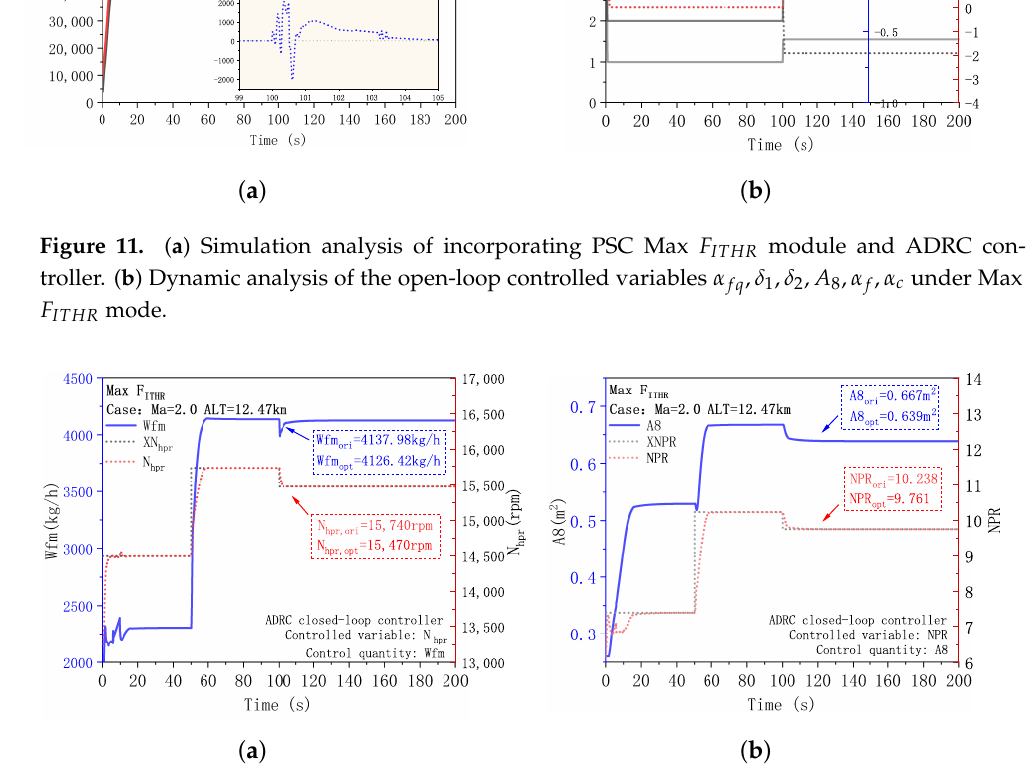
Figure 12. ( a ) Dynamic analysis of the controlled variables wfm and N hpr under Max F ITHR mode. ( b ) Dynamic analysis of the controlled variables A8 and NPR under Max F ITHR mode.